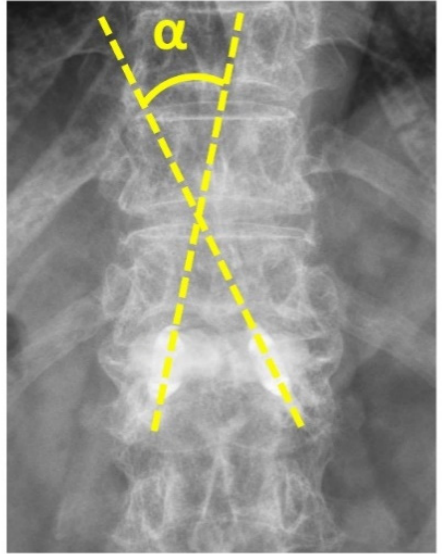
Figure 3. The AP view of radiographic image shows the angle between the two expanded devices ( α angle).